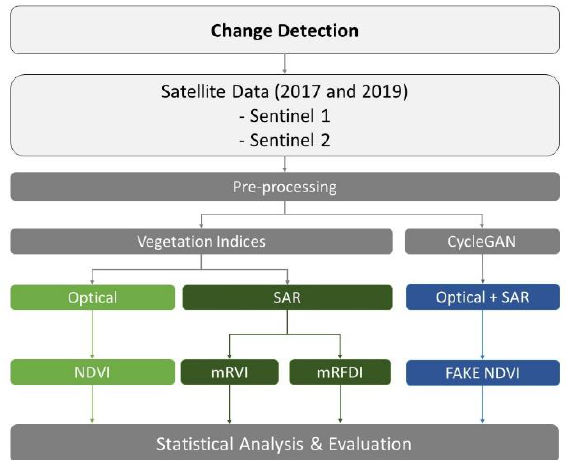
Figure 3. Flowchart of the